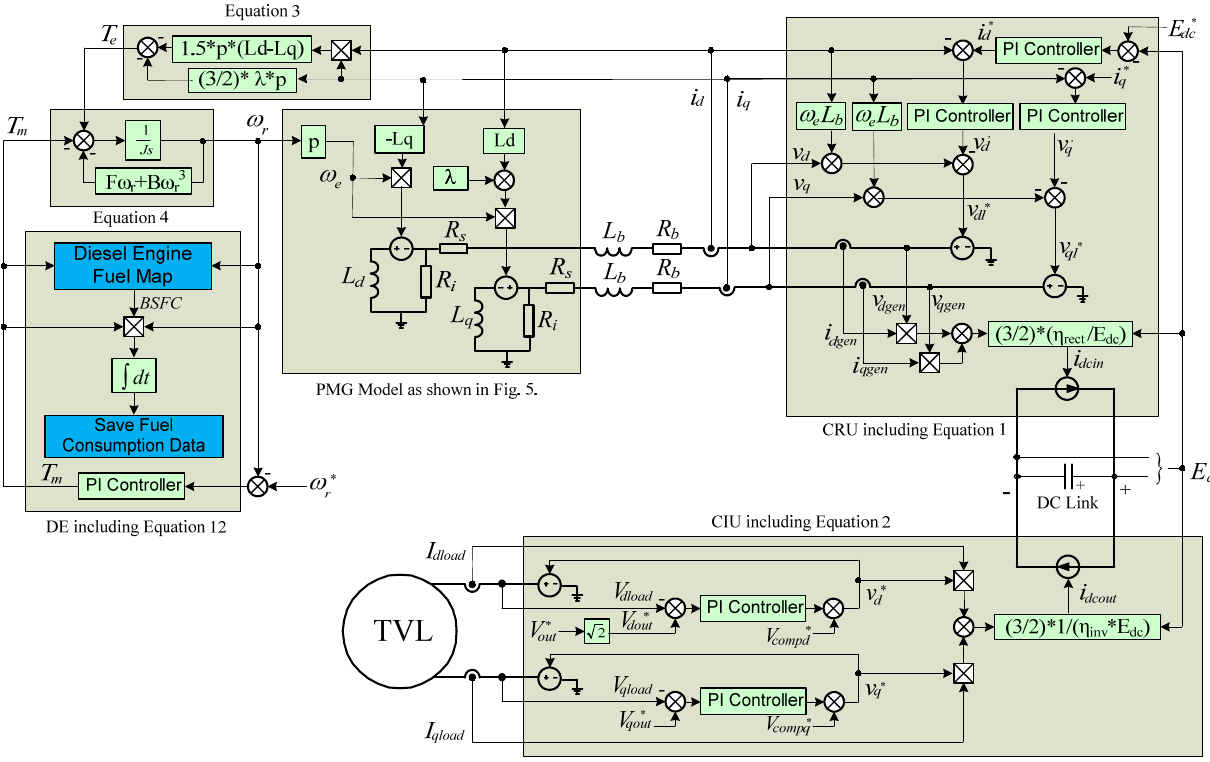
Figure 5. Schematic of the complete DQ mathematical